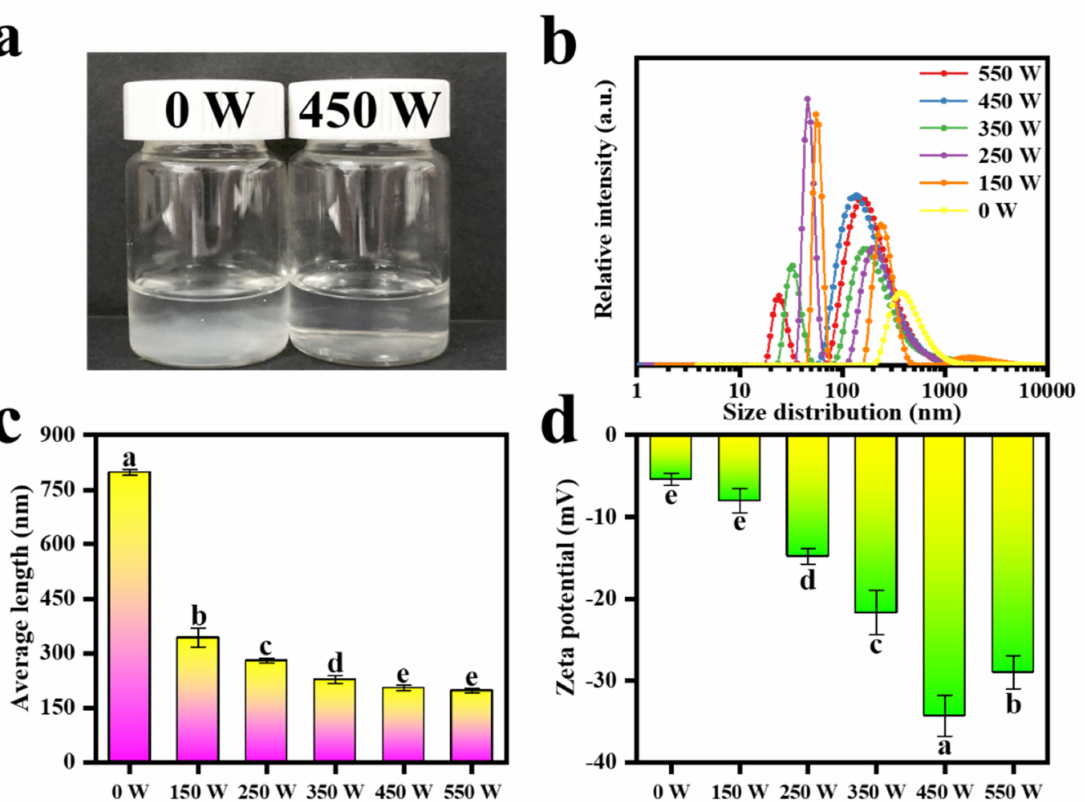
Figure 3. Photograph of TOCNFs suspension treated at 0 W and 450 W ultrasonic power ( a ). The size distribution diagram of TOCNFs at different ultrasonic power (0, 150, 250, 350, 450, and 550 W) ( b ). Average length ( c ) and ζ − potential ( d ) diagram of TOCNFs at different ultrasonic power (0, 150, 450, 250, 350, 450, and 550 W). Different letters of a, b, c, d and e show significant